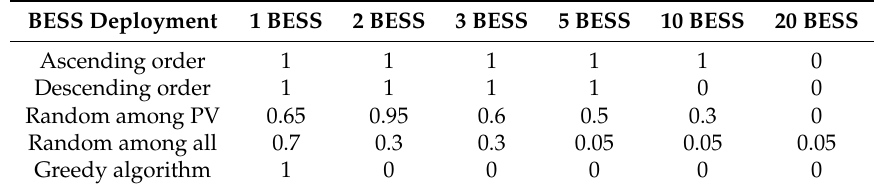
Table 5. Probability of voltage violation for 300% PV penetration and different BESS deployments.